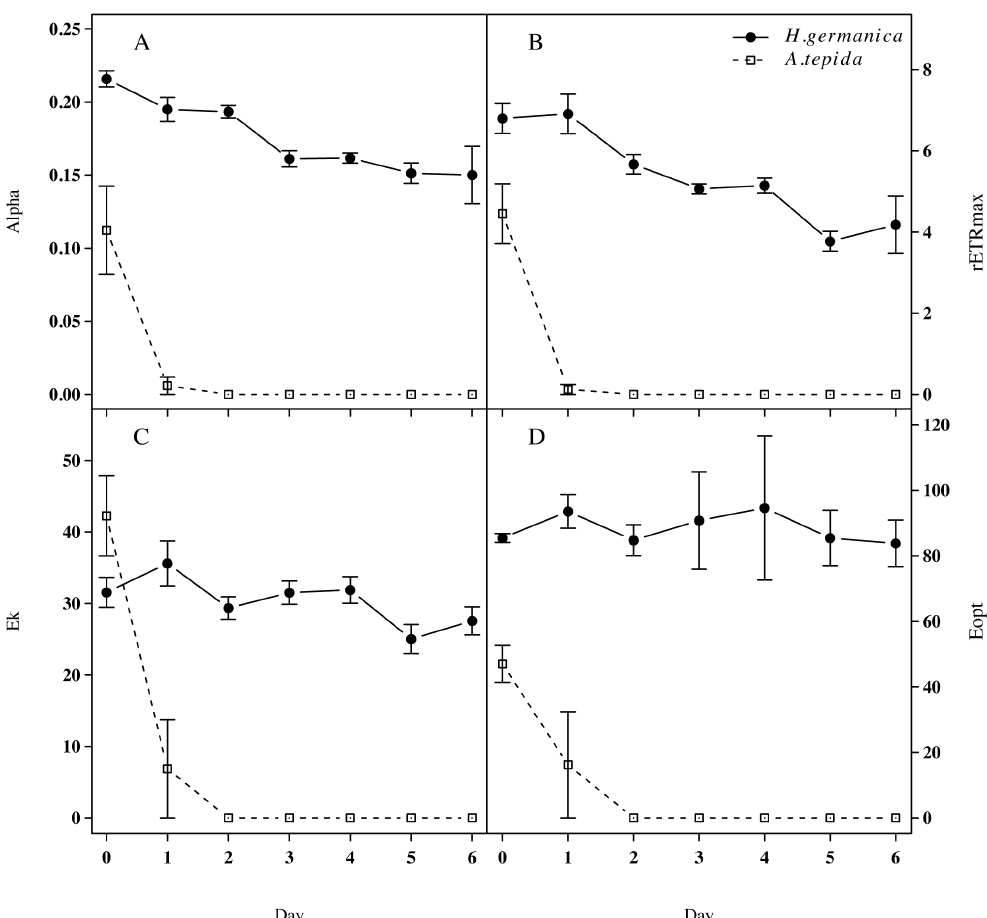
Figure 6. Rapid light curve (RLC, n = 3) parameters for Haynesina germanica (Dark-RLC) and Ammonia tepida maintained in the dark during the experiment, Alpha is the initial slope of the RLC at limiting irradiance, rETRmax is the maximum relative electron transport rate, Ek is the light saturation coefficient and Eopt is the optimum light, all of them were estimated by adjusting the experimental data to fit the model of Platt et al.